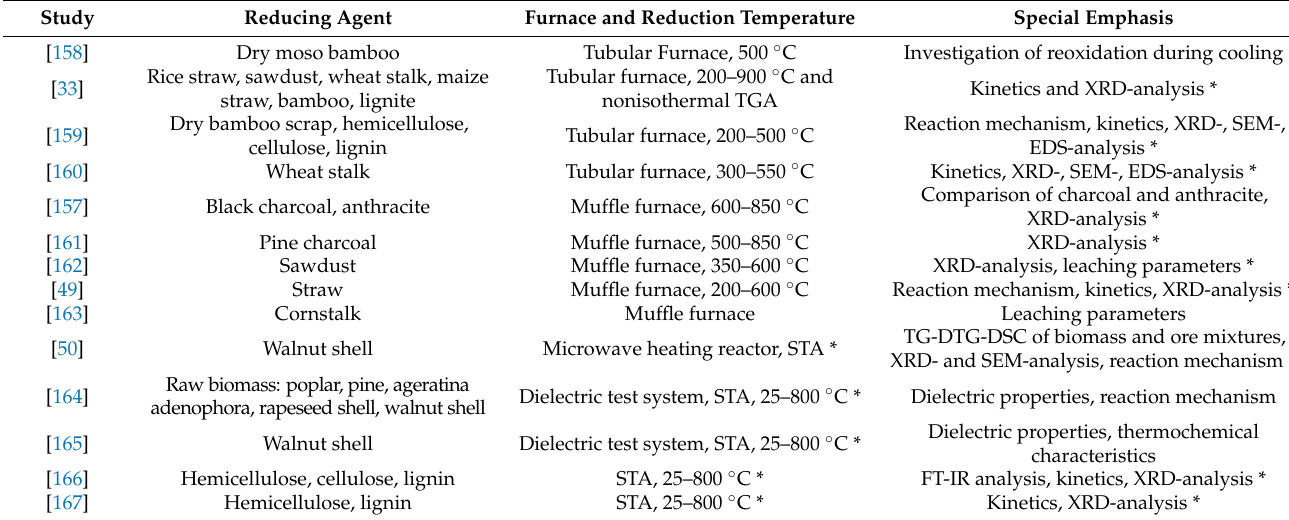
Table 6. Studies carried out investigating the reduction roasting